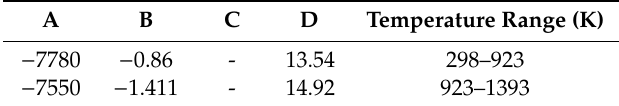
Table 1. Evaporation constant of